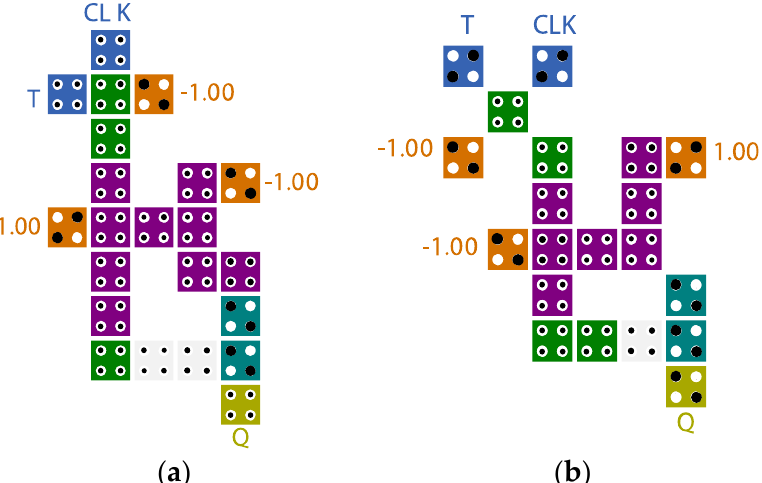
Figure 8. Proposed level-sensitive T flip-flops (LST-FFs). ( a ) The first LST-FF (LST-FF1) and ( b ) the second LST-FF (LST-FF2).